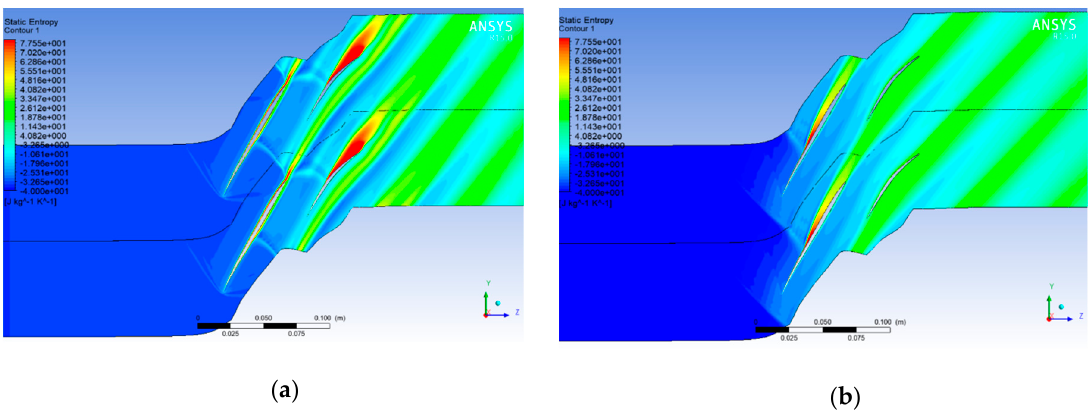
Figure 7. The entropy increment contours at inlet Mach number 1.2. ( a ) at the DE point, ( b ) at the NS point.